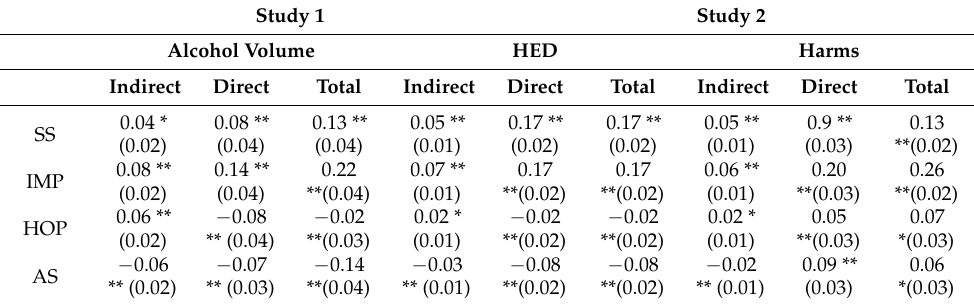
Table 2. Standardized indirect effects and standard errors of personality traits on alcohol outcomes through protective behavioral strategies, standardized direct effects, and standardized total effects.